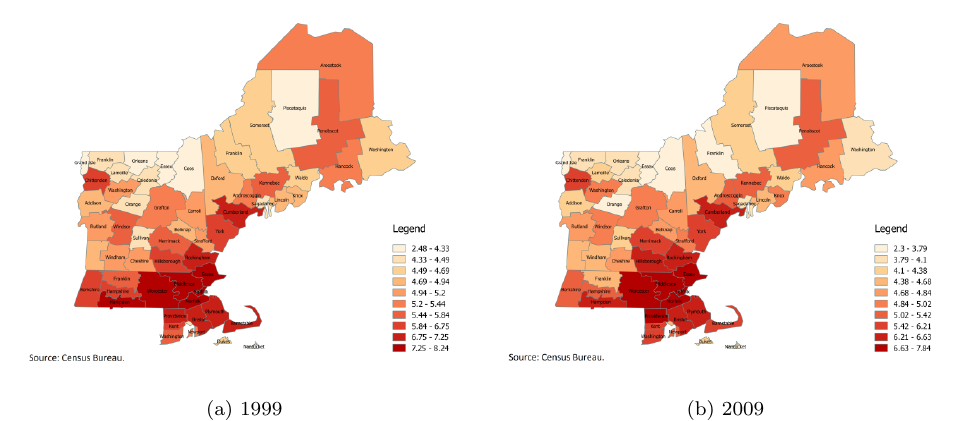
Figure 2: Spatial variation of single-unit firm births in 1999 and